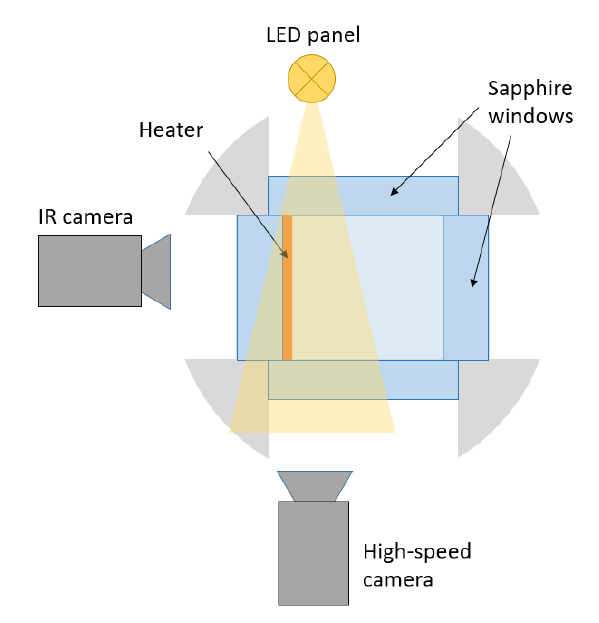
Figure 4. Operating measurement principles.